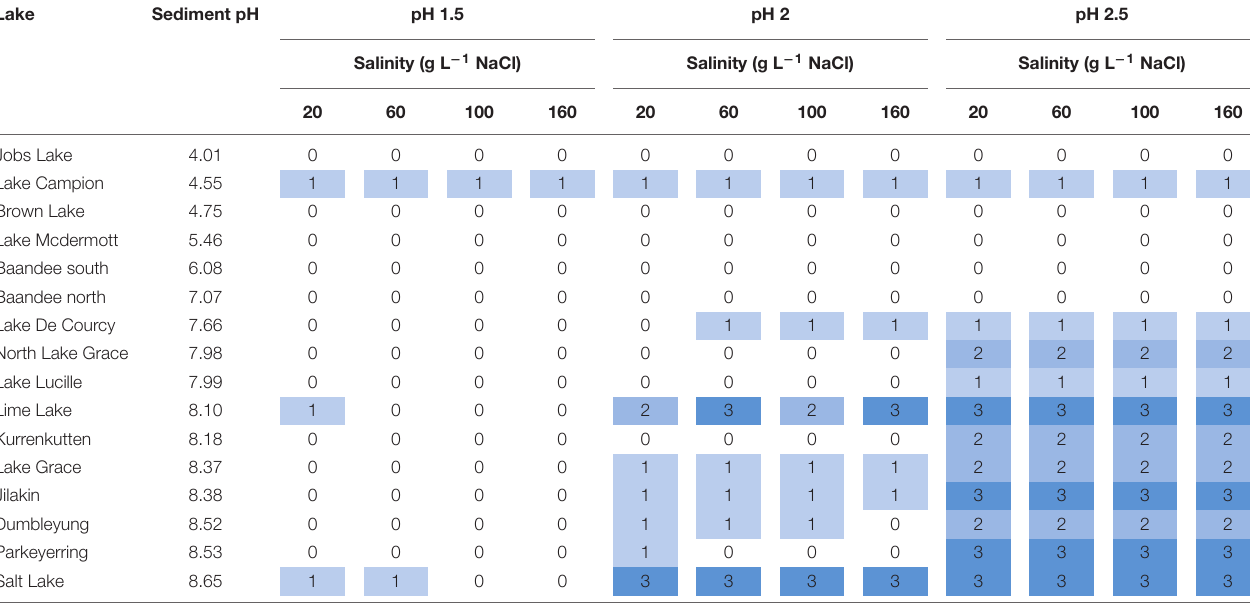
TABLE 3 | Iron oxidation activity in acidic, saline enrichment cultures. Lake